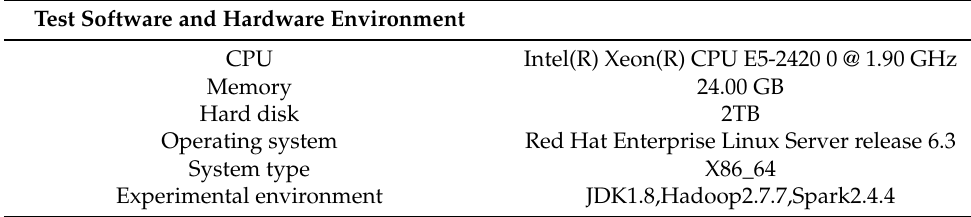
Table 7. Experimental environment